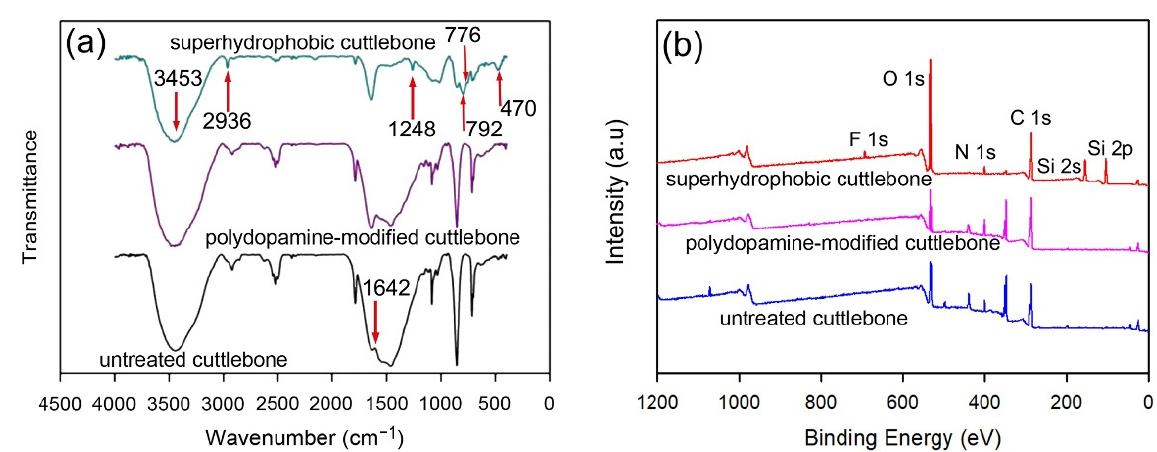
Figure 5. FTIR spectra ( a ) and XPS spectra ( b ) of the untreated cuttlebone, the polydopamine-modified cuttlebone, and the superhydrophobic cuttlebone.